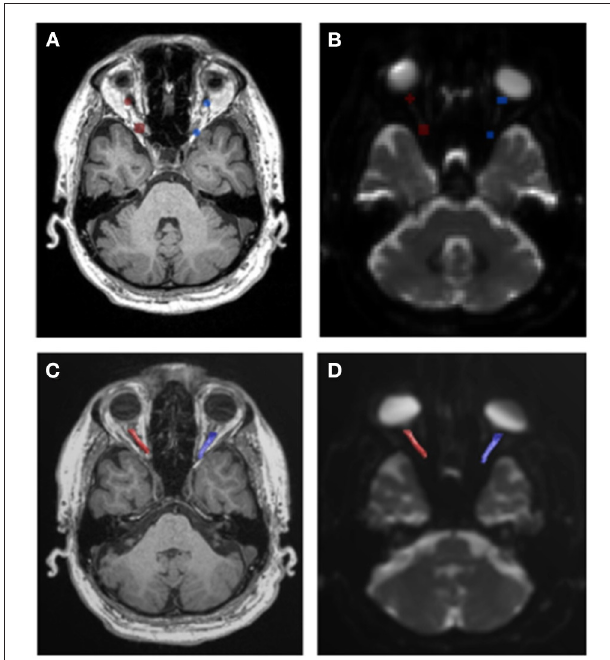
FIGURE 3 | Geometric distortion in diffusion magnetic resonance images. (A,B) When there was a difference between the locations of the ROIs of the T1-weighted image and b0 image, we choose b0 images to locate the ROI. (C,D) Final tractography is well-matched with the b0 image rather than the T1-weighted